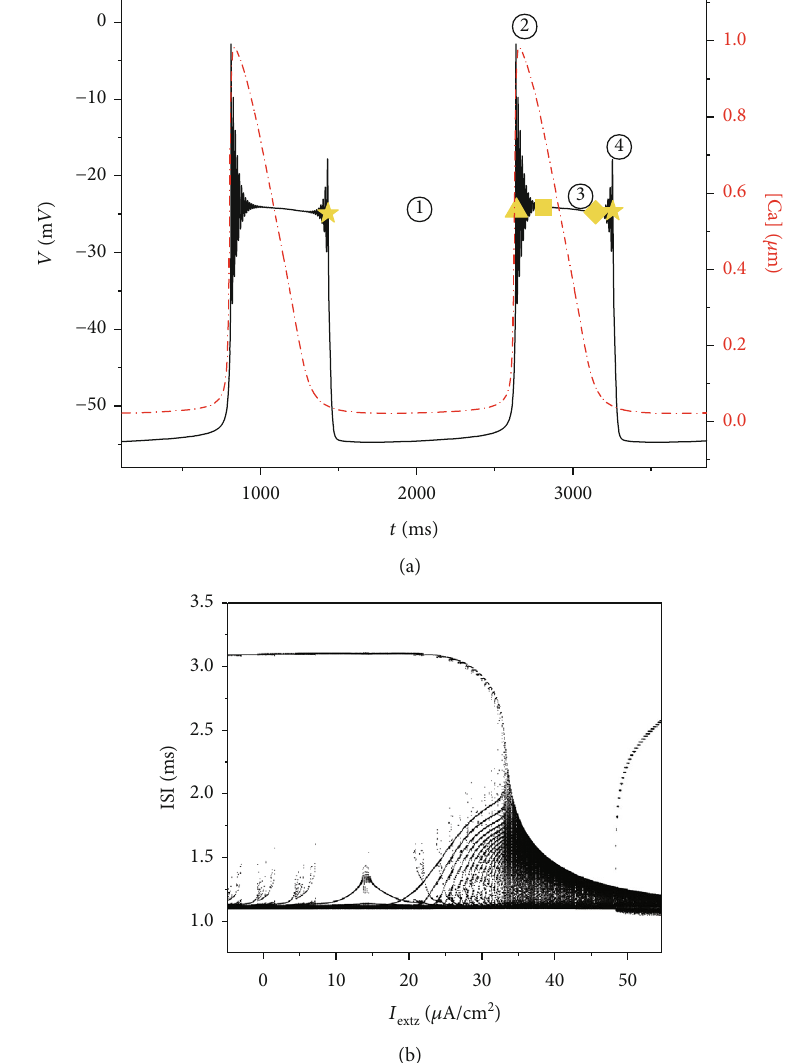
Figure 4: (a) Partial enlarged area of Figure 3(a). Yellow symbols mark key points along the solution trajectory (star: start of phase ① ; triangle: start of phase ② ; square: start of phase ③ ; diamond: start of phase ④ ); (b) the bifurcation diagram of ISI versus I